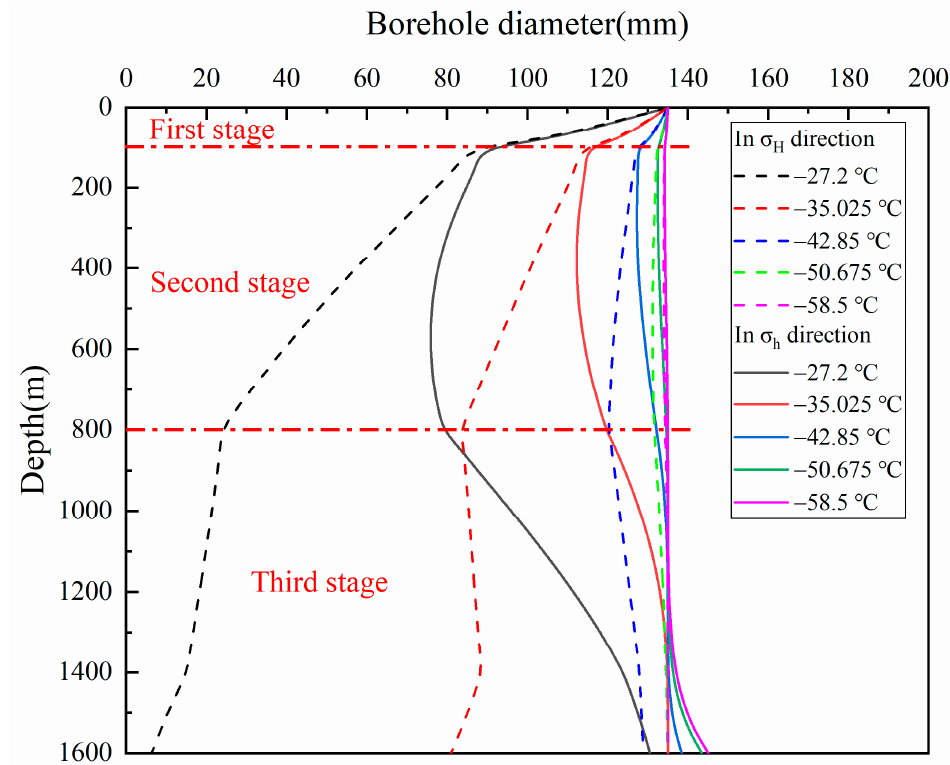
Figure 7. Sensitivity analysis of changes in borehole diameter with surface temperature in one